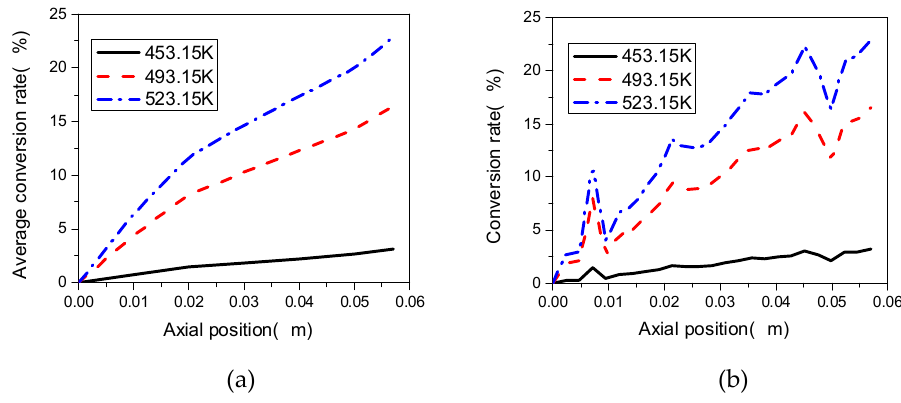
Figure 15. Effect of initial temperature of barrel on conversion rate at ( a ) Line 2; ( b ) the whole TSE.